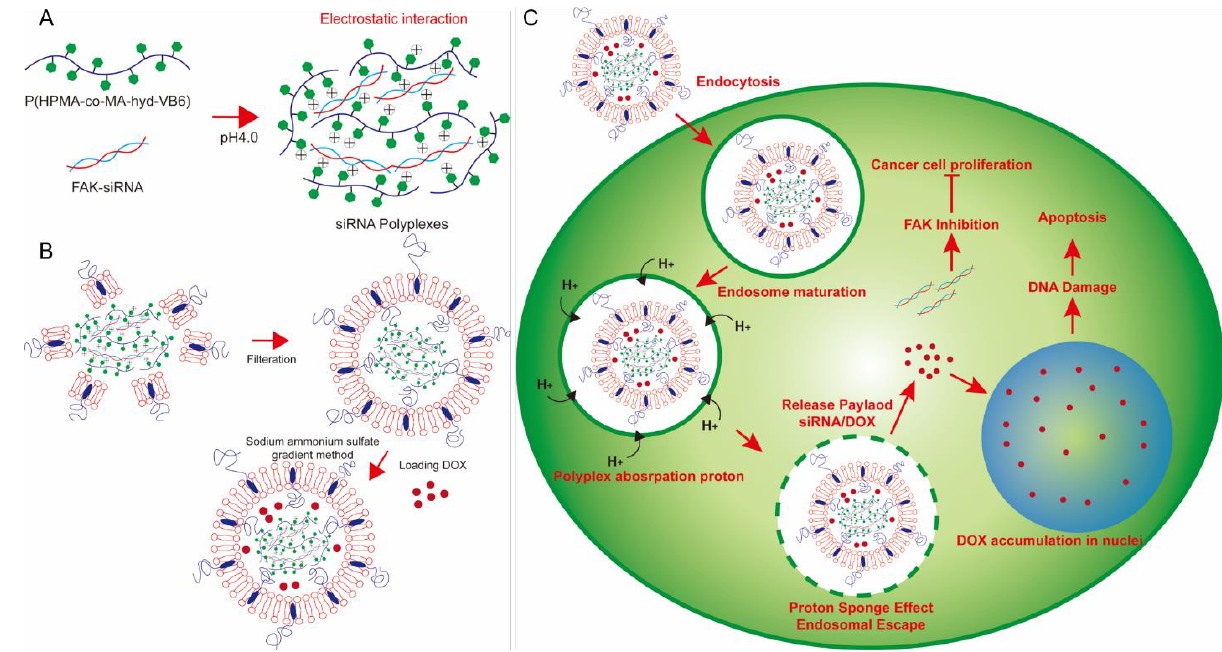
Figure 1. The concept of DOX-loaded lipopolyplexes for cancer chemo-gene therapy. ( A ) At pH 4.0, P(HPMA- co -MA- hyd -VB6) copolymers could absorb protons to become positive charges for electrostatic interaction with negatively charged FAK siRNA to form gene-loaded polyplexes. ( B ) The gene-loaded polyplexes were then encapsulated and DOX were loaded into PEGlyated-liposomes using a sodium ammonium sulfate gradient method to form lipopolyplexes. ( C ) After cancer cells internalized lipopolyplexes via an endocytosis process, P(HPMA- co -MA- hyd -VB6) copolymers induced proton sponge effect and simultaneously deformed the structures of lipopolyplexes and endosomes for releasing FAK siRNA and DOX into cell cytosols for cancer chemo-gene therapy.